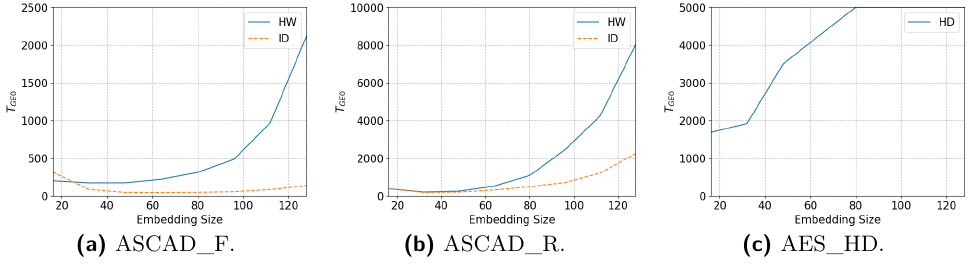
Figure 7: The effect of embedding